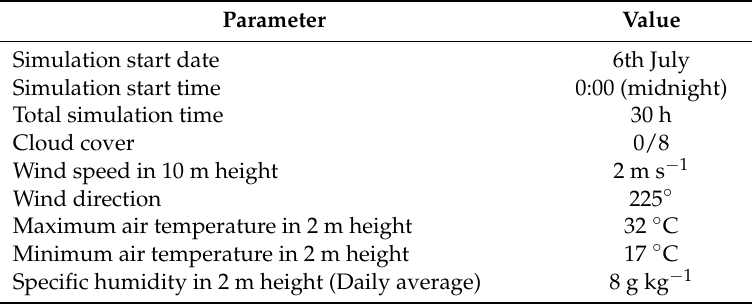
Table 3. Initial and boundary conditions for the ENVI-met model runs.